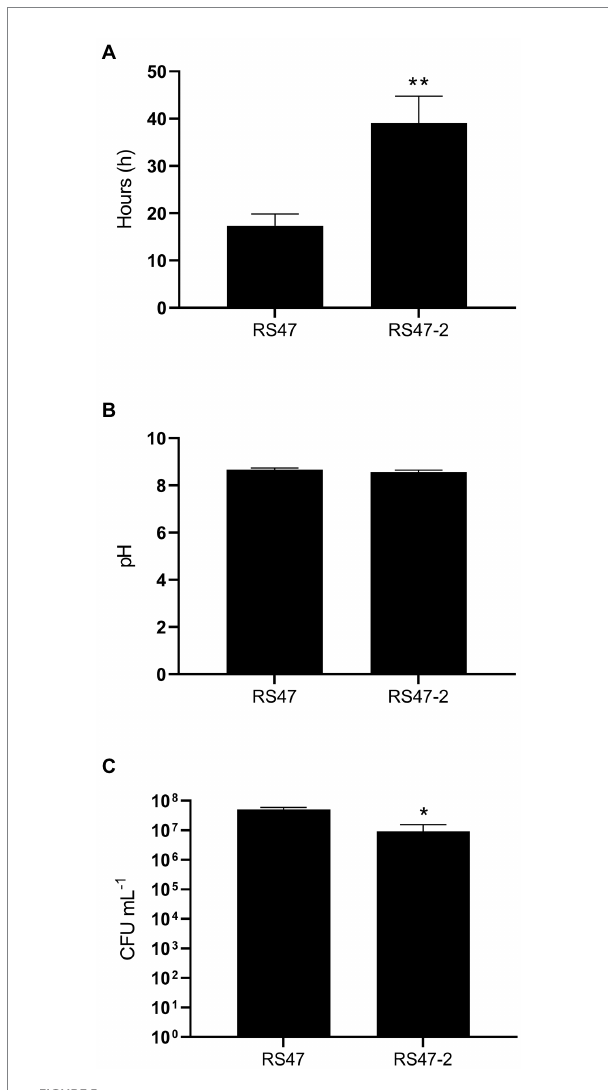
FIGURE 5 Impact of waaC disruption on crystalline biofilm formation. In vitro bladder models were used to simulate infection of the catheterized urinary tract. (A) Time taken for catheters to block in models inoculated with the RS47 WT or RS47-2 mutant. (B) pH of residual bladder urine at time of catheter blockage . (C) Number of viable cells in residual bladder urine at time of catheter blockage. Data represents the mean of a minimum of five biological replicates and error bars represent SEM. * p ≤ 0.05; ** p ≤